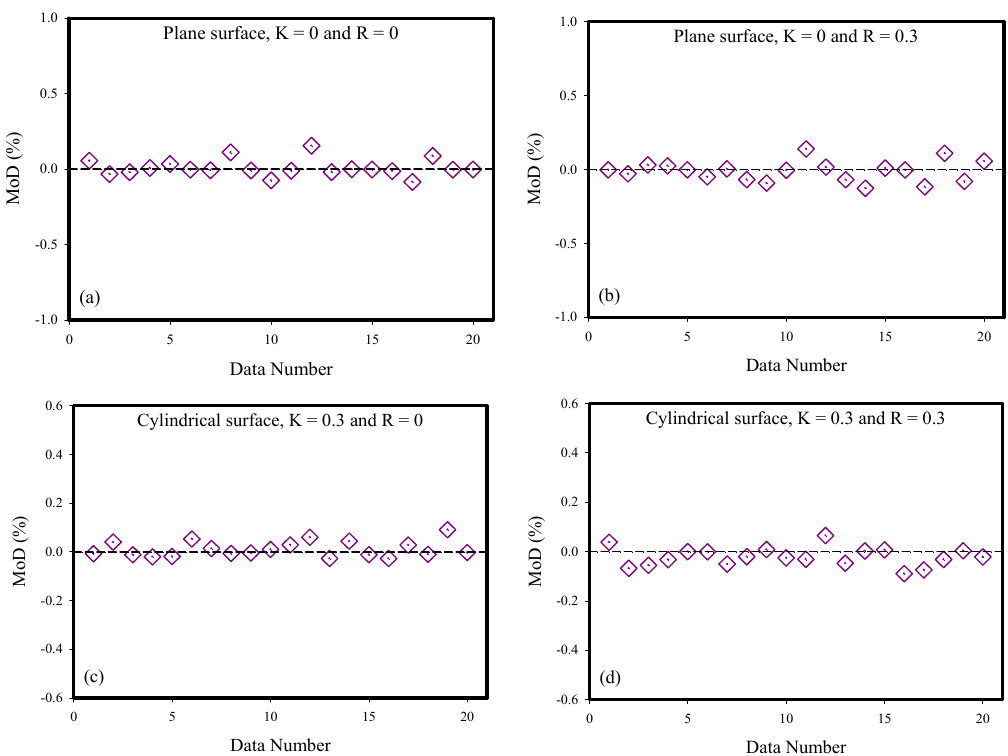
Figure 8. ANN predictions and target values according to data number for thermal Flow Regimes–I ( a ), -II ( b ), -III ( c ), and -IV ( d ).